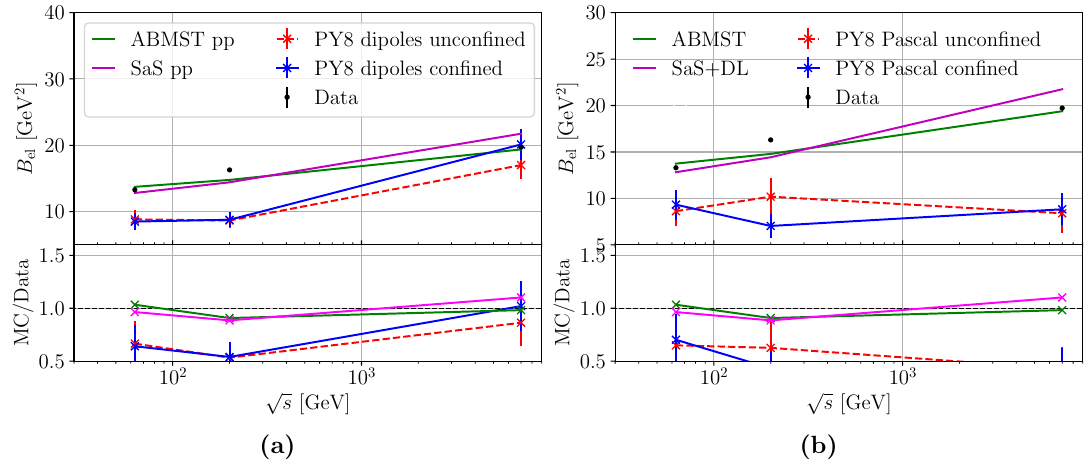
Figure 10. The elastic slope for pp collisions as a function of p s for the dipole (a) and Pascal (b) models. Both show the con(cid:12)ned and uncon(cid:12)ned versions in solid blue and dashed red lines, respectively. Both (cid:12)gures show the ABMST (solid green lines) and SaS+DL (solid magenta lines) for